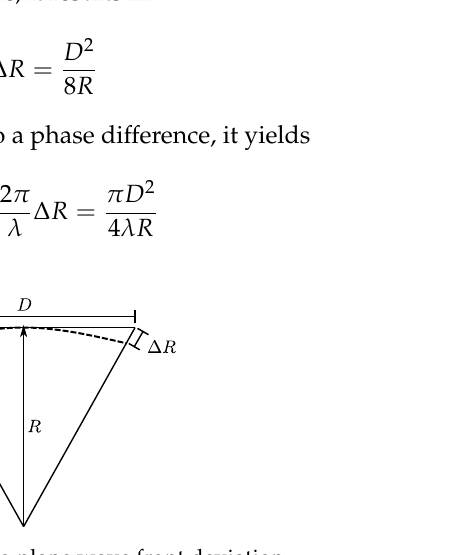
Figure 6. Spherical to plane wave front deviation.